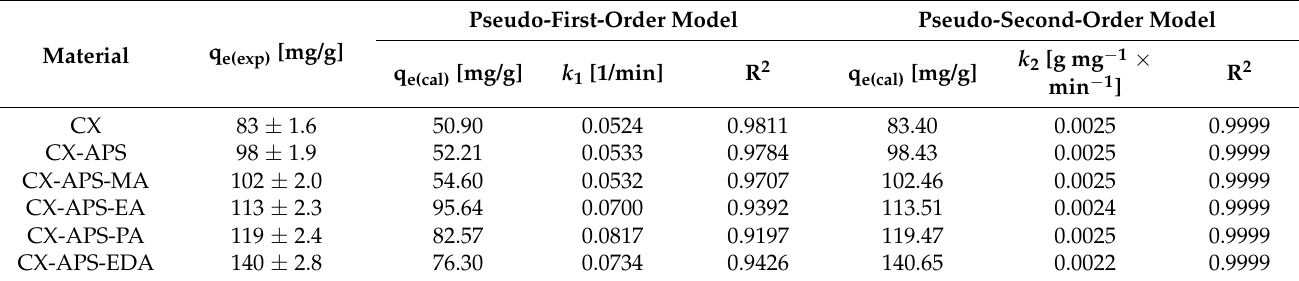
Table 4. Kinetic parameters for the adsorption of thymol blue on the surface of carbon xerogels.